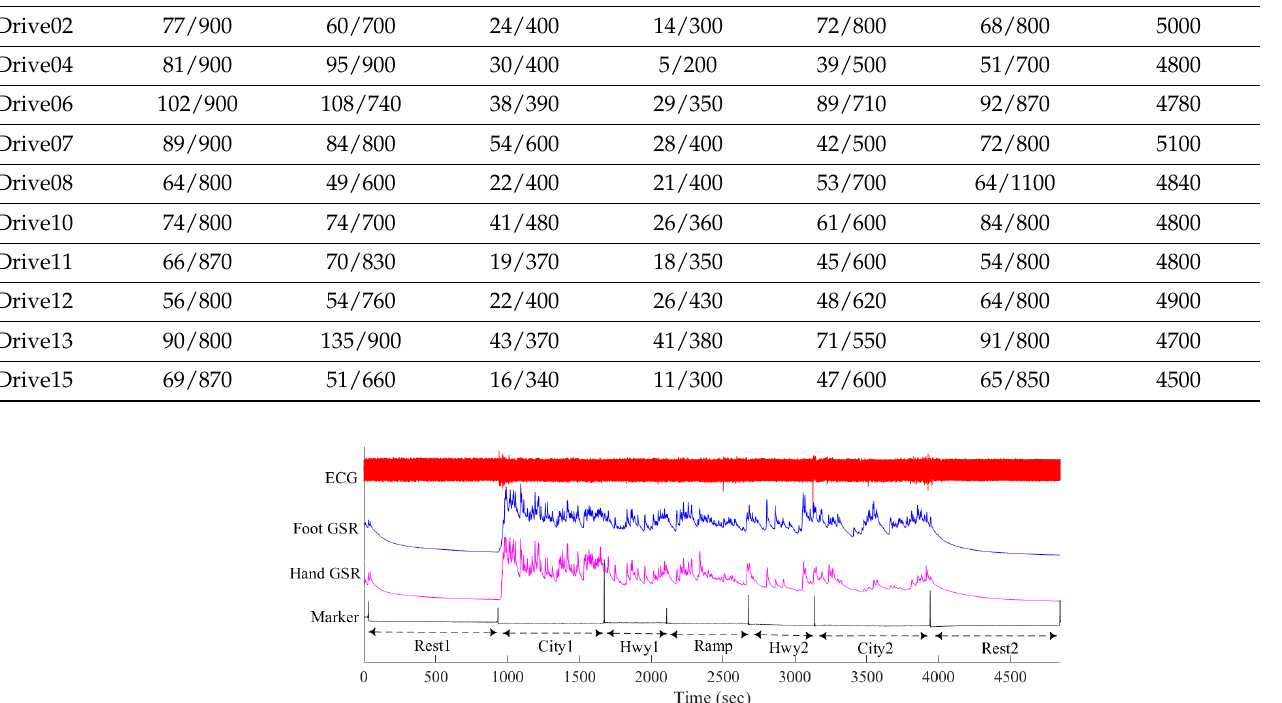
Table 1. Time and sample size after segmentation of the 10 driving datasets.